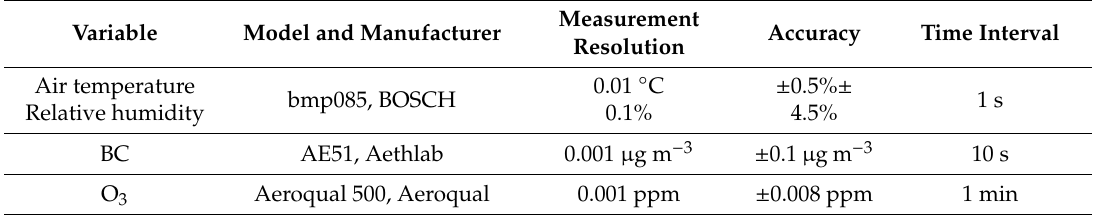
Table 1. Specifications of instruments used for UAV